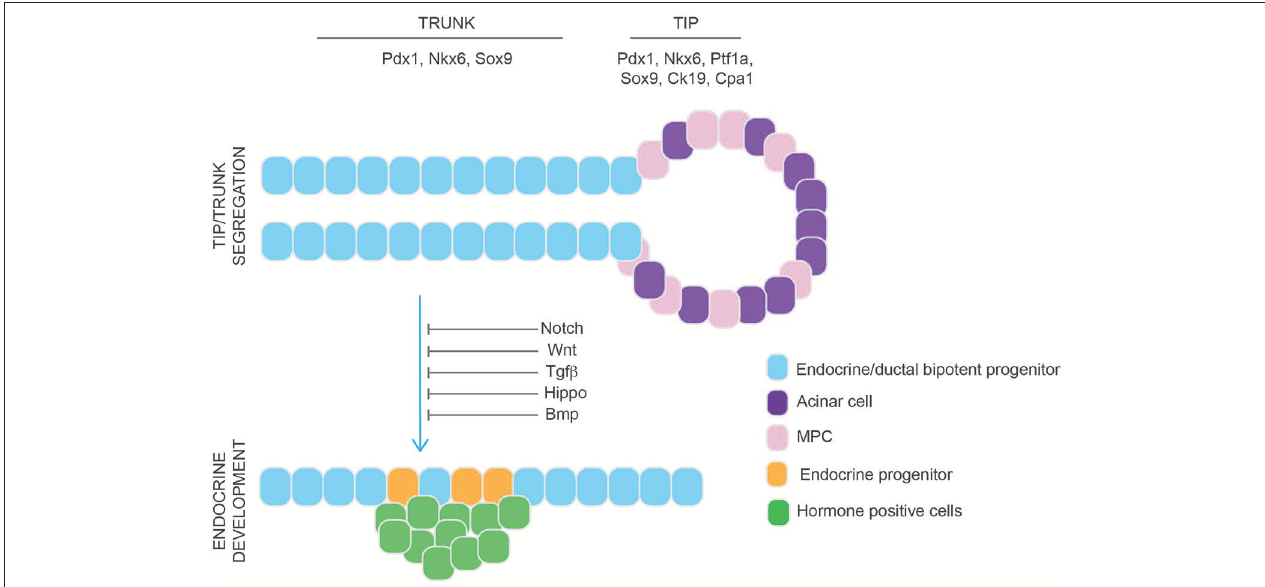
FIGURE 9 | Schematic representation of murine pancreatic development. Multipotential Pancreatic Cells (MPC) (pink) and acinar cells (purple) are located at the tip of the pancreatic epithelium. The trunk contains endocrine/ductal bipotent progenitors (light blue) that migrate out of the epithelium and differentiate to endocrine progenitor cells (orange) which give rise to hormone positive cells (green cells). Endocrine commitment is driven by inhibition of Notch, Wnt, Tgf- β , Hippo, and Bmp signaling pathways.